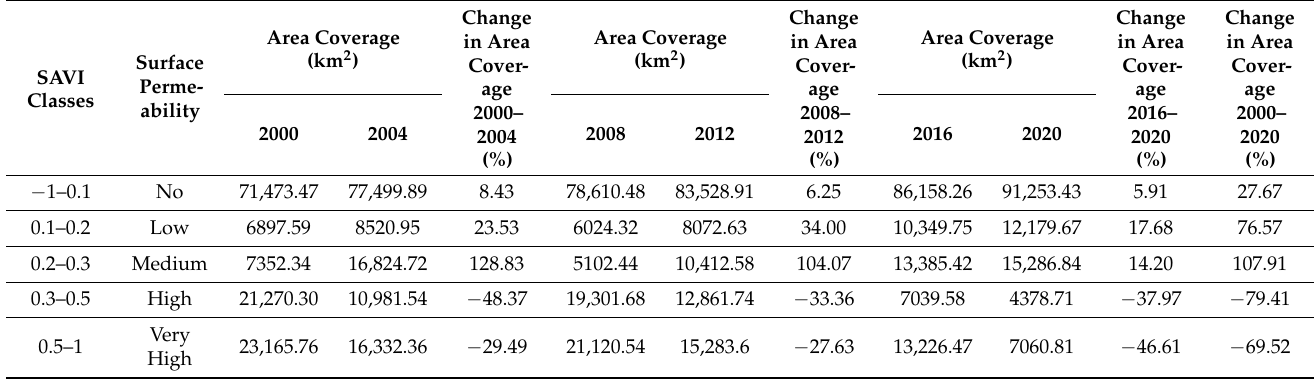
Table 7. Change analysis of soil moisture for Tamil Nadu for two decades between 2000–2020.